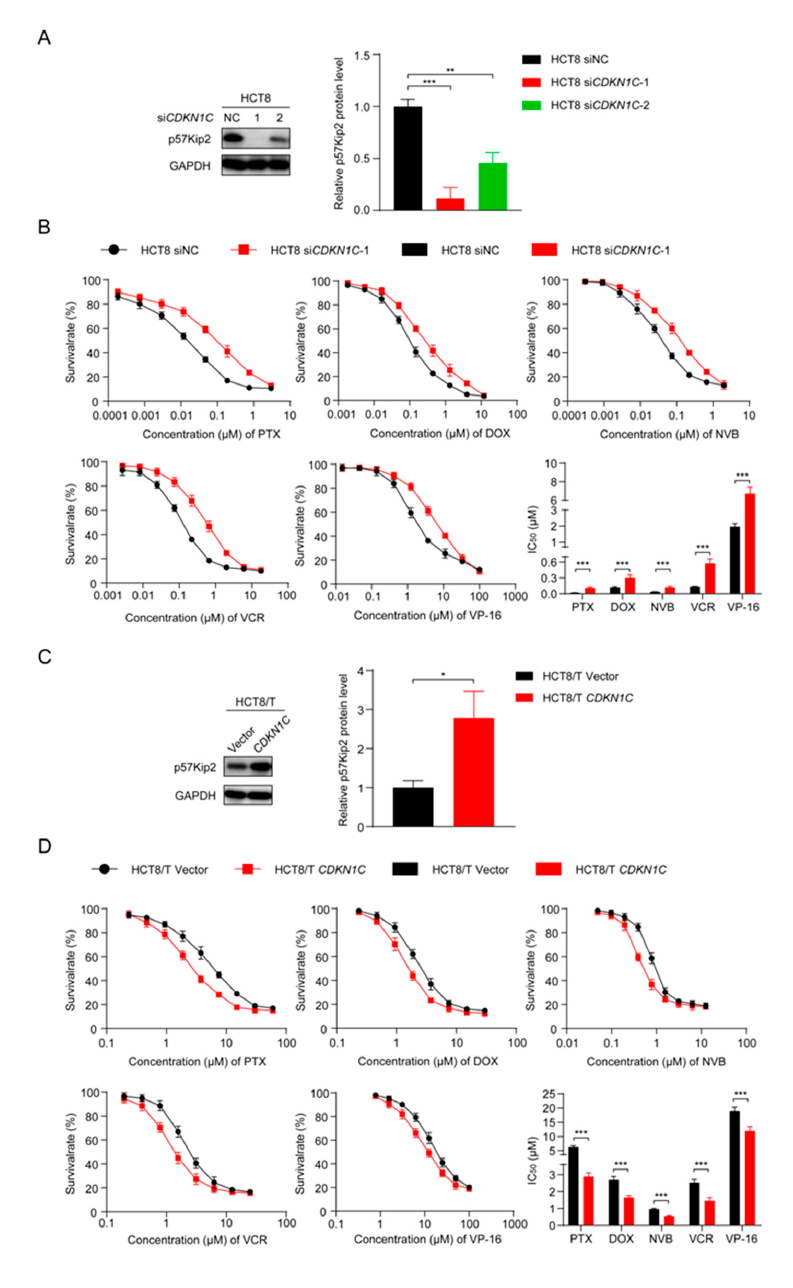
Figure 4. CDKN1C increases the sensitivity of HCT8 and HCT8/T cells to chemotherapeutic